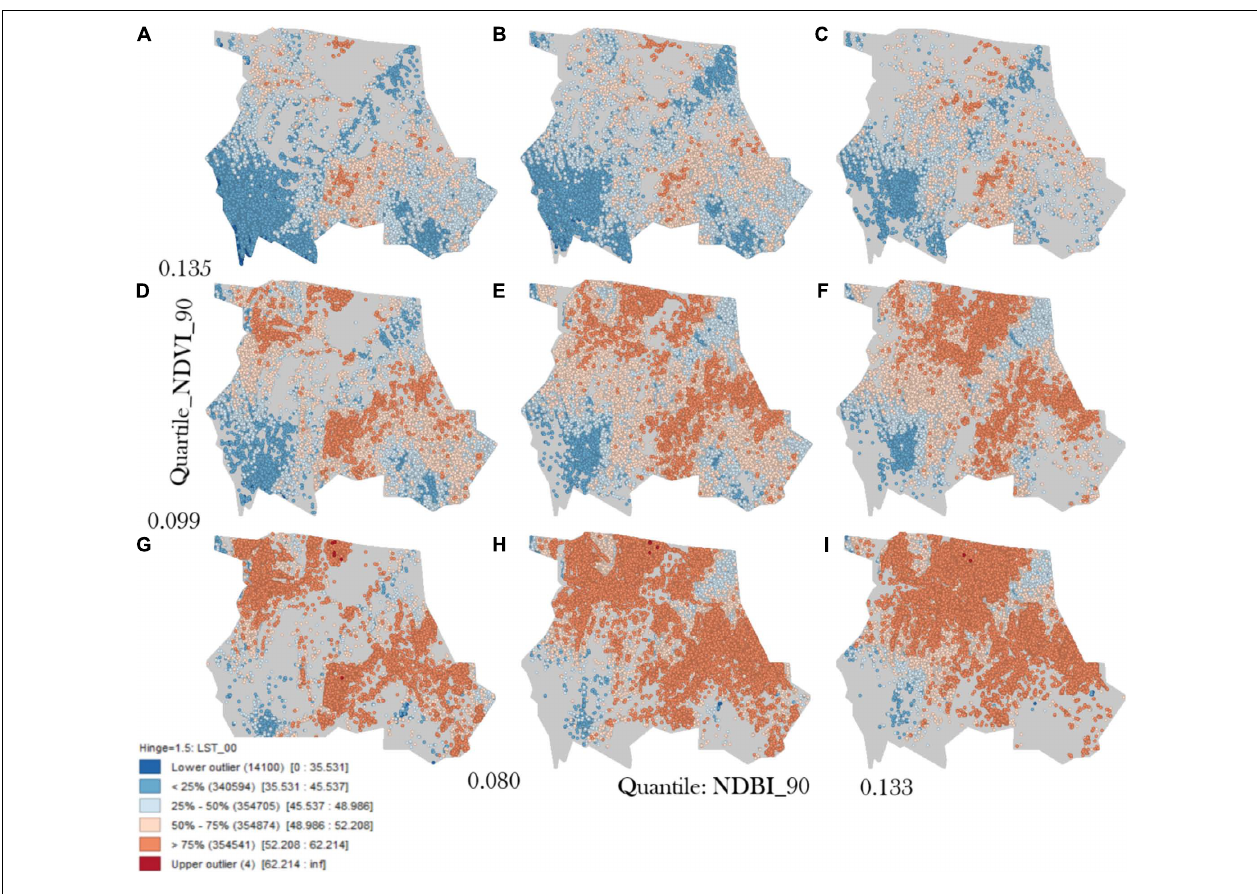
FIGURE 7 | (A–I) Conditional map of LST based on NDBI and NDVI for